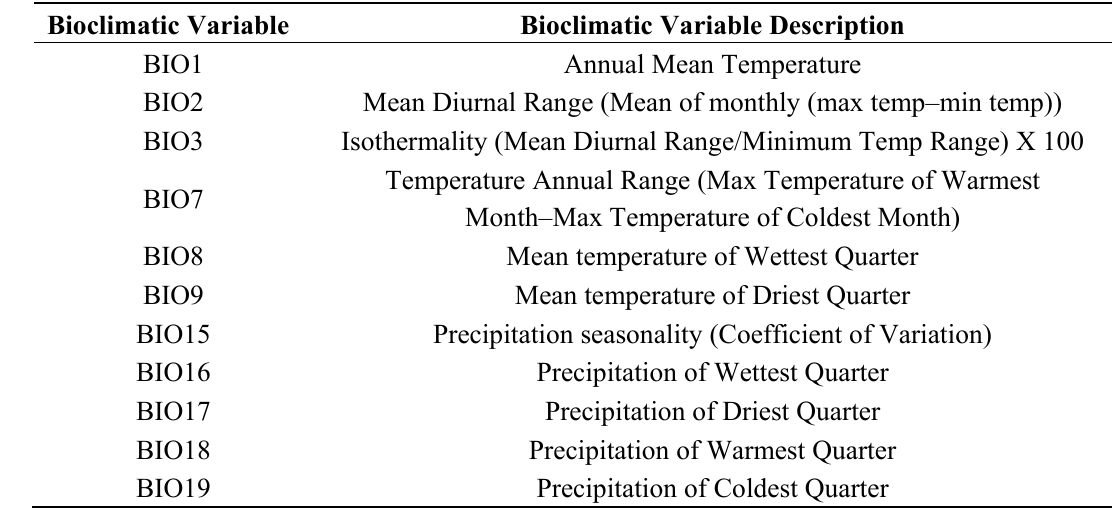
Table 4. Bioclimatic variables used to model the climatic niche for priority salamanders based on current and 2050 projected climate scenarios (CCSM4 (CCSM) and HadGEMCC-2 (Hadley)) in the northeastern